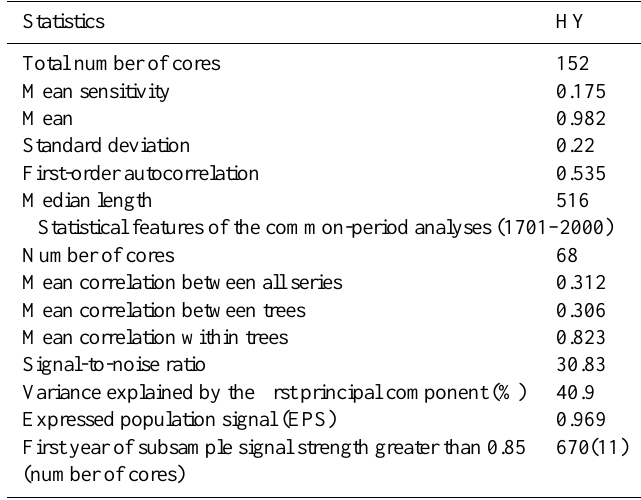
Table 2. Statistical features of the HY